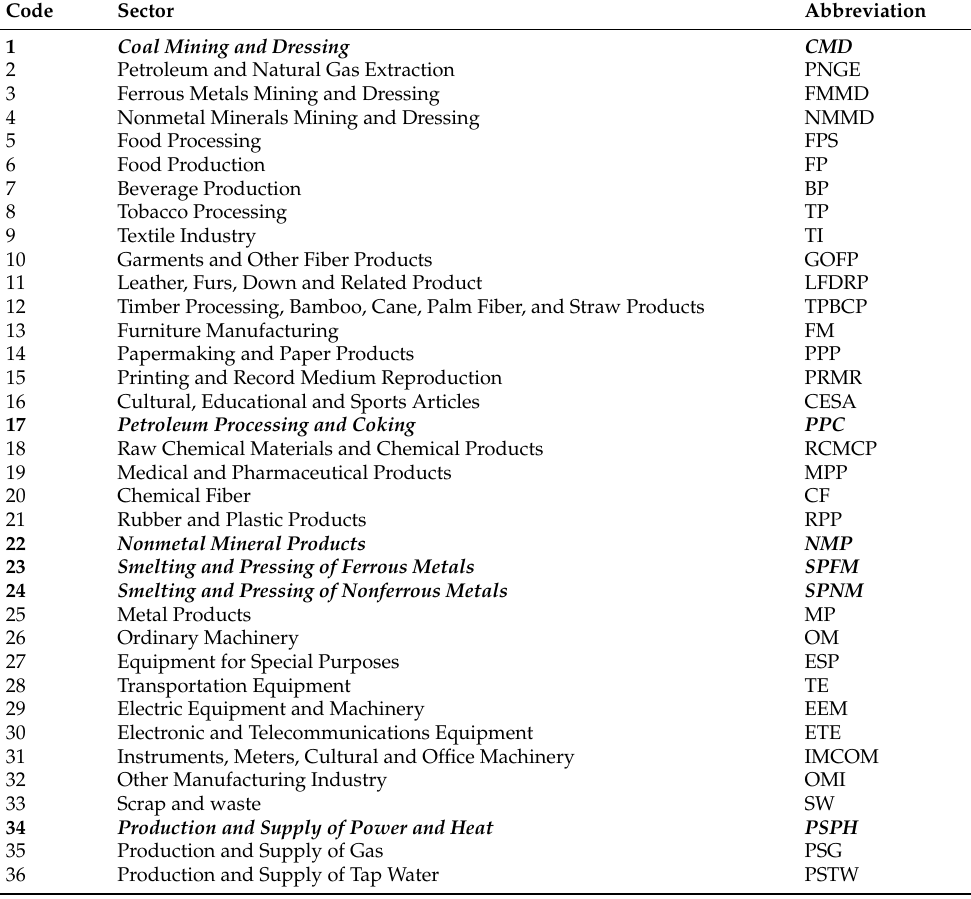
Table 2. Sector classification and